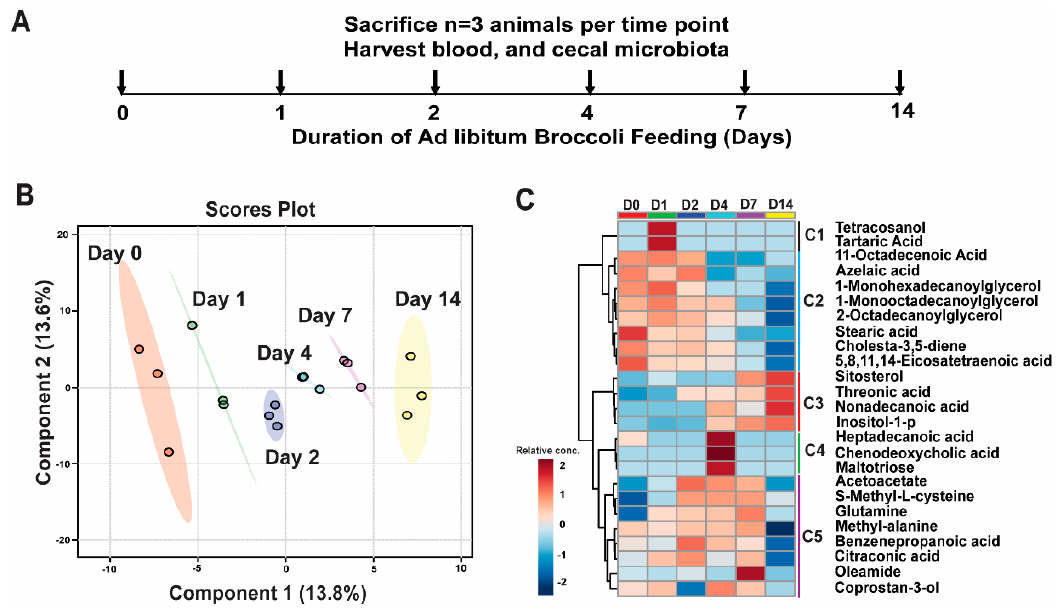
Figure 1. Broccoli feeding alters plasma metabolite composition ( A ) Experimental timeline ( B ) PLSDA plot of plasma metabolite composition. ( C ) Hierarchical clustering of the top 25 metabolites that contributes to PLSDA plot in 1A. D0 = Day 0.